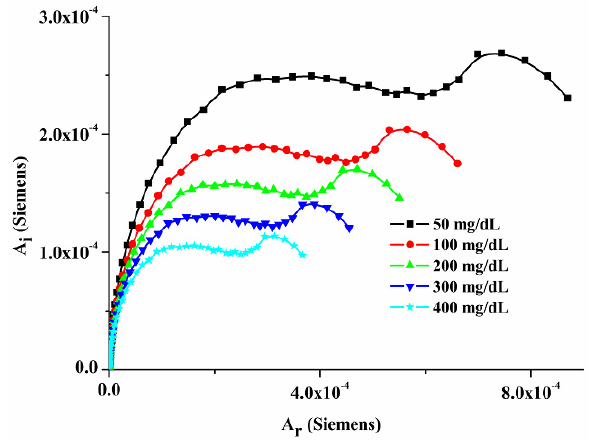
Fig. 6: A typical representation of complex Admittance plot of different glucose